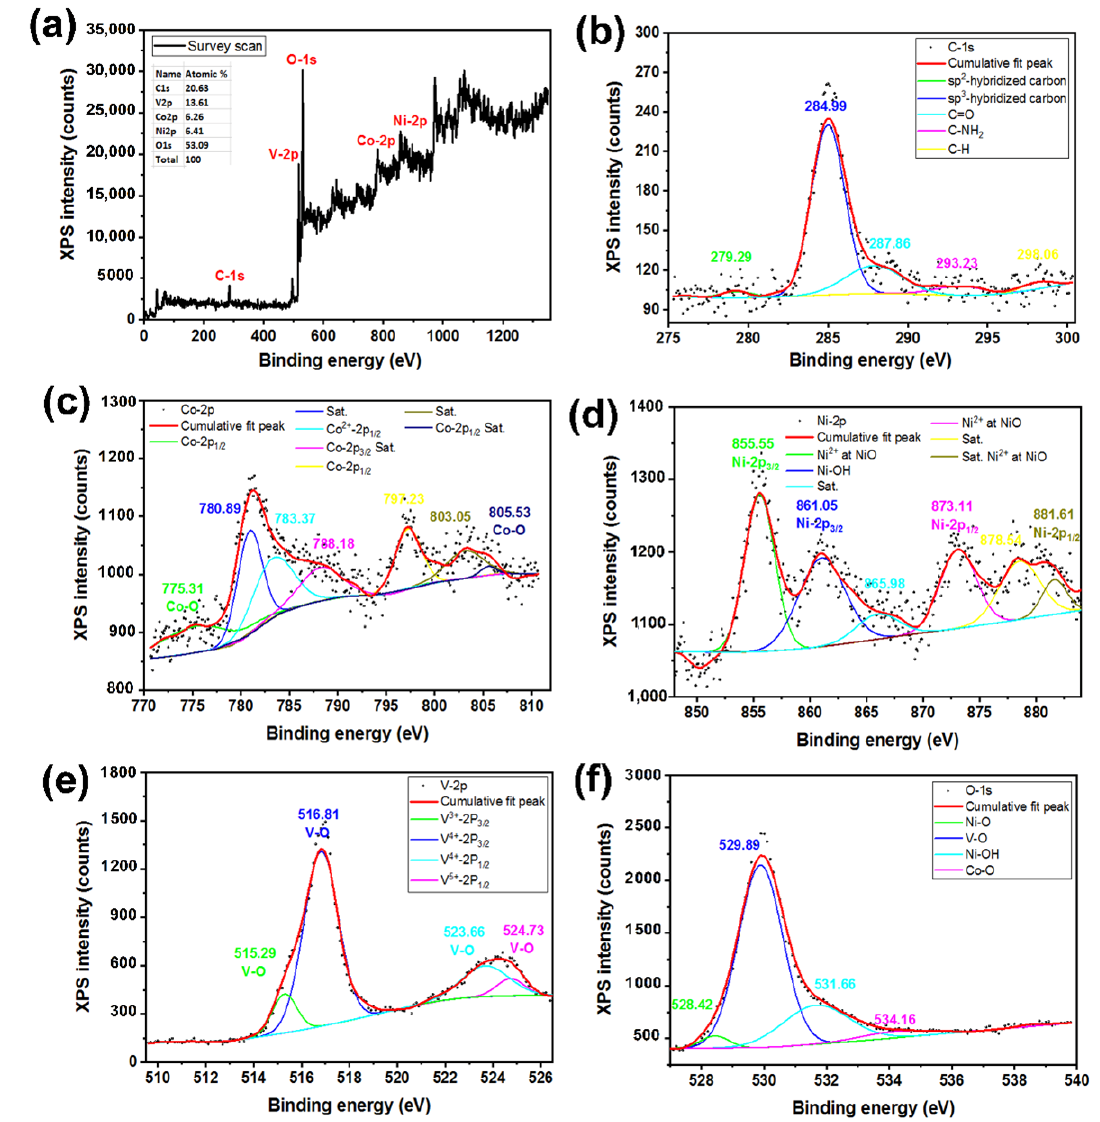
Figure 7. XPS of a Co x NiV y O z layer coated on a Ni foam@rGO substrate, ( a ) survey scan, ( b ) C-1 s , ( c ) Co-2 p , ( d ) Ni-2 p , ( e ) V-2 p , and ( f ) O-1 s.